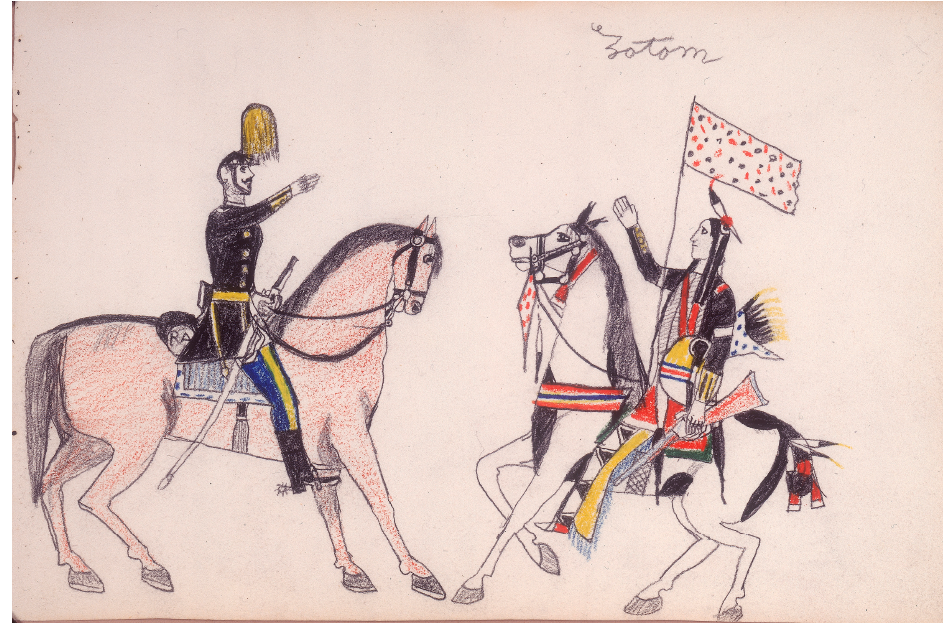
Figure 5. Ledger drawing by Zó ̱ ta ̂ m (Driftwood). In it, Zó ̱ ta ̂ m recounts his meeting with an American army officer during 1871. Credit: Braun Research Library Collection, Autry Museum, Los Angeles, California: 4100.G.1.24.